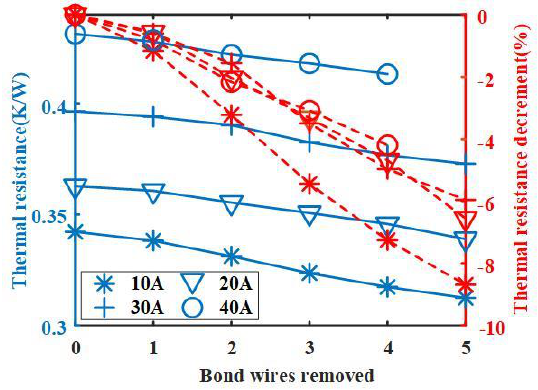
Figure 17. Measured thermal resistance after bond wires lift-off. Table 3. Thermal resistance (K/W) under different working conditions after bond wires removed.